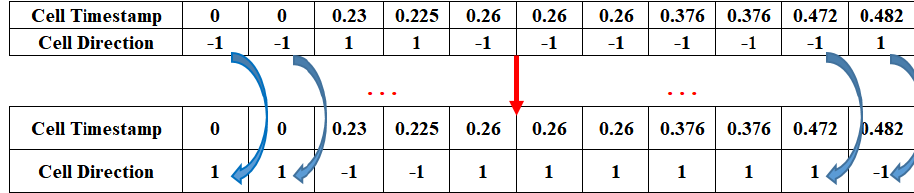
Figure 12. Data augmentation (add data).